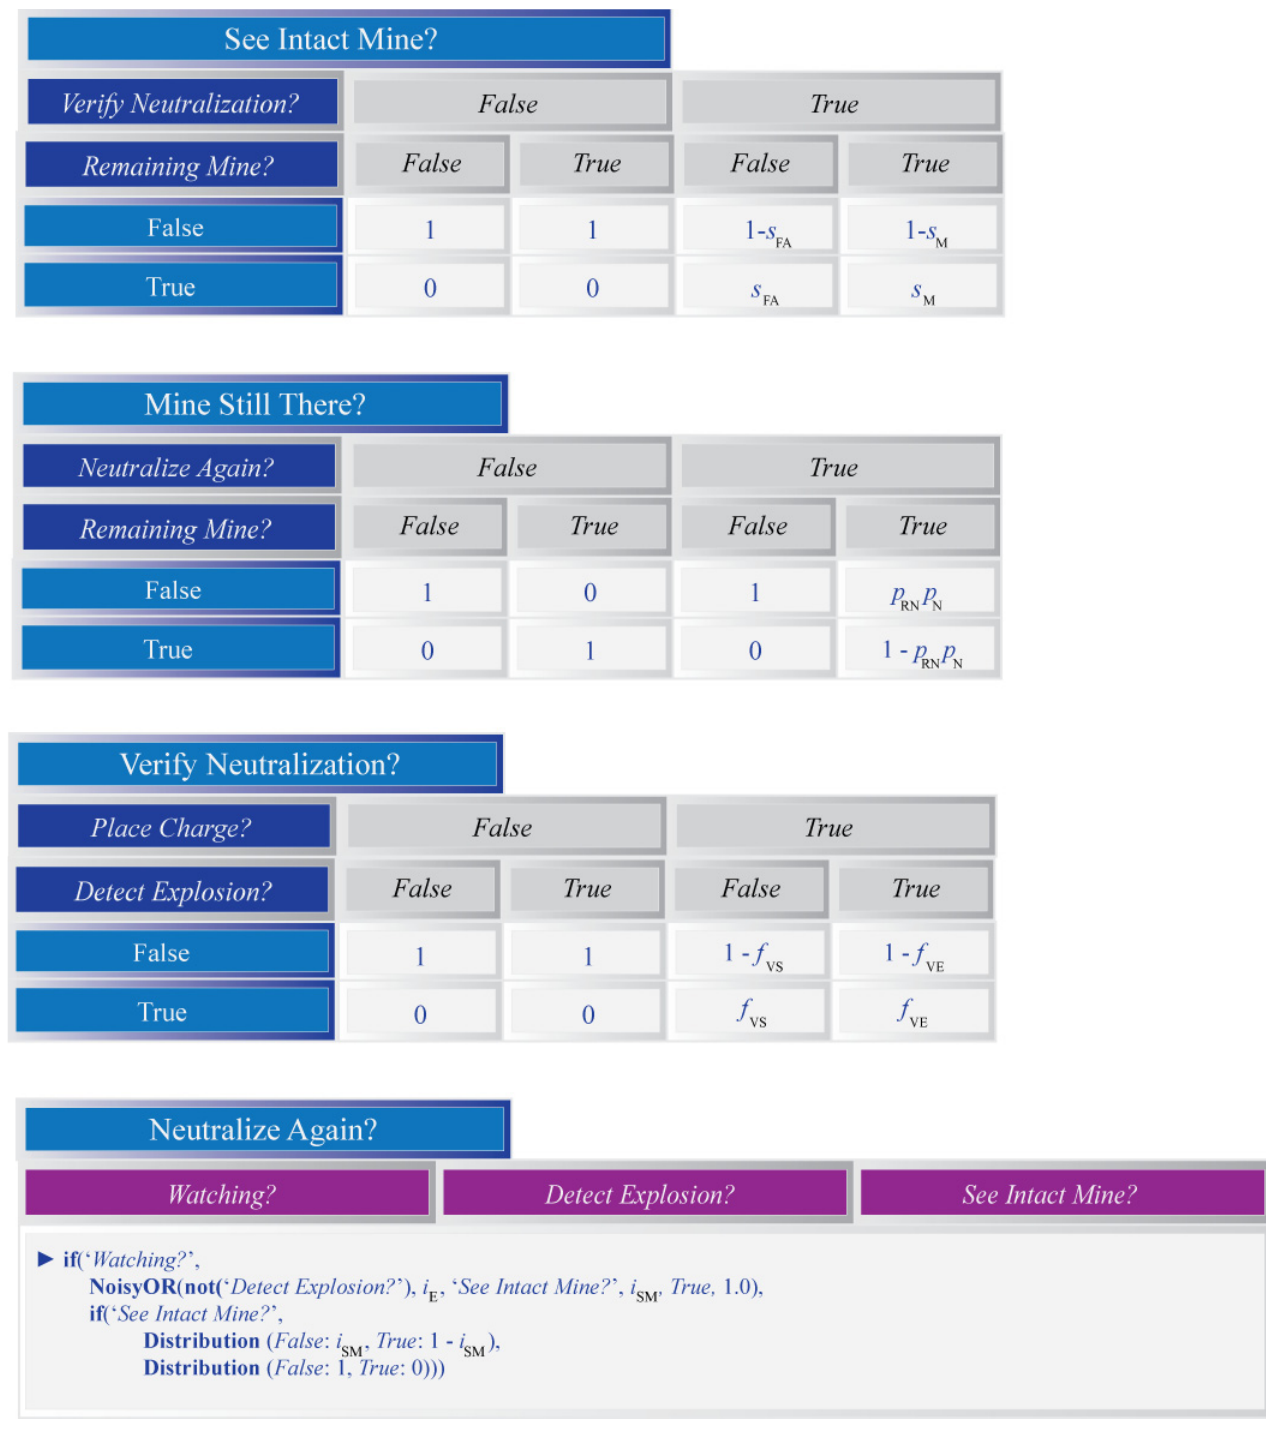
Figure A3. The last set of conditional probability tables for the Bayesian network that will be used to model inference within each grid cell. The table for the ‘ Neutralize Again? ’ variable is defined using Hugin’s NoisyOR, if and Distribution expressions. More information on these may be found in the Hugin documentation.